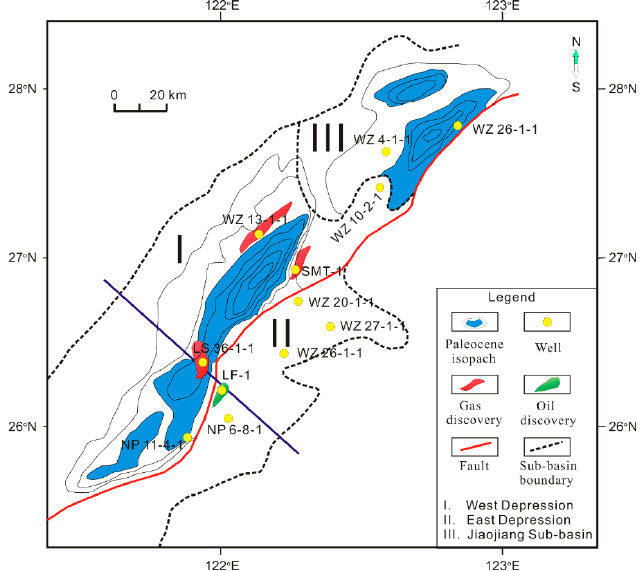
Figure 11. Location map of major hydrocarbon fields, non-commercial discoveries, and sub-units of the Lishui Sub-basin. Blue areas indicate the regions of the mature source rocks (modified from Chen et al. [3]).